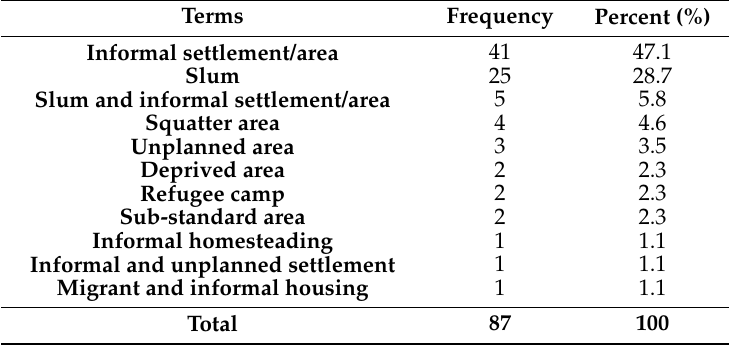
Frequency of publications using a specific term (within the reviewed remote sensing